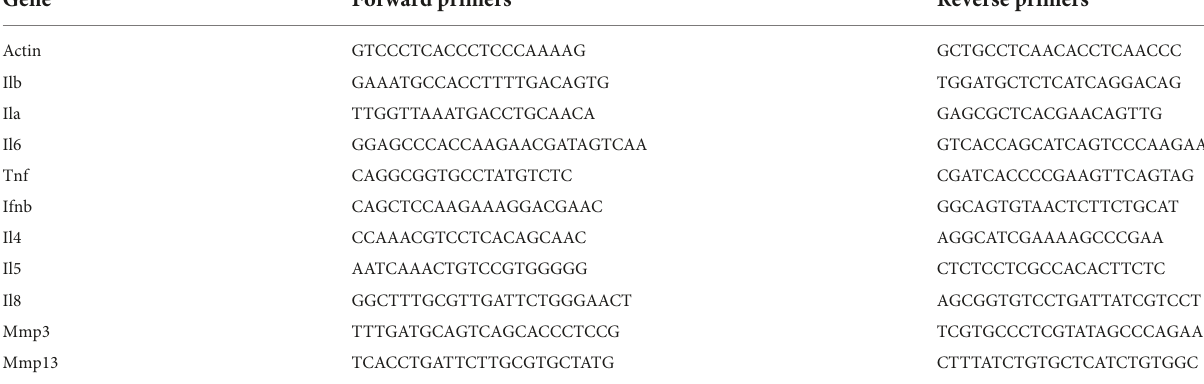
TABLE 1 Primer sequences for quantitative